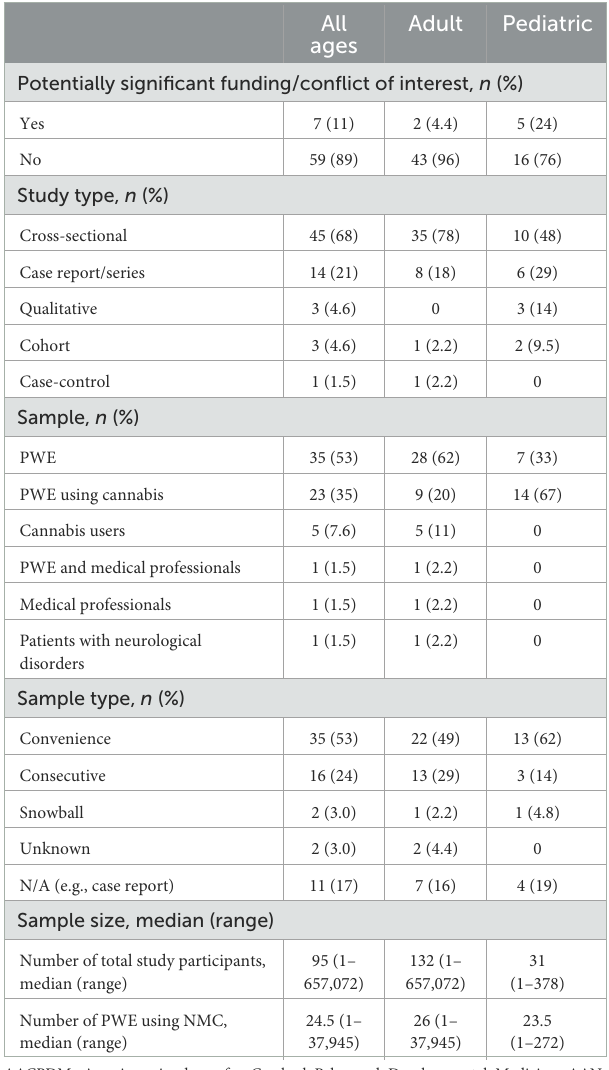
TABLE 2 Publication identification and study characteristics between adult and pediatric studies.